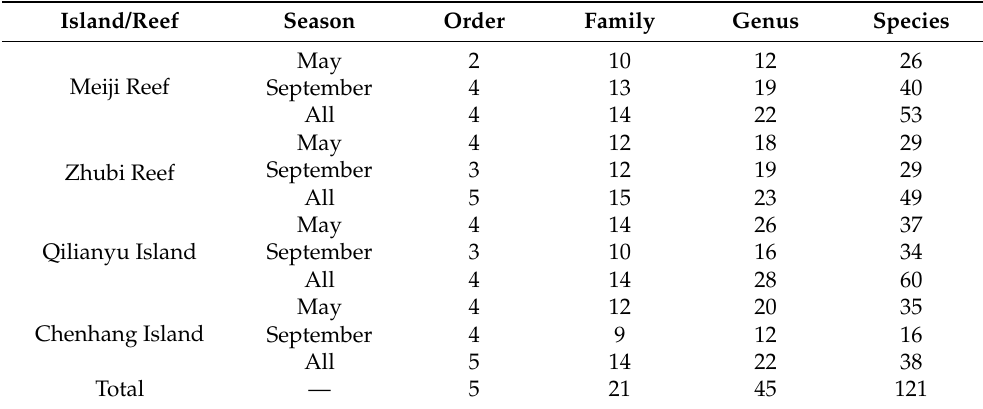
Table 1. Number of fish species in Meiji Reef, Zhubi Reef, Qilianyu Island and Chenhang Island in the South China Sea in May and September.